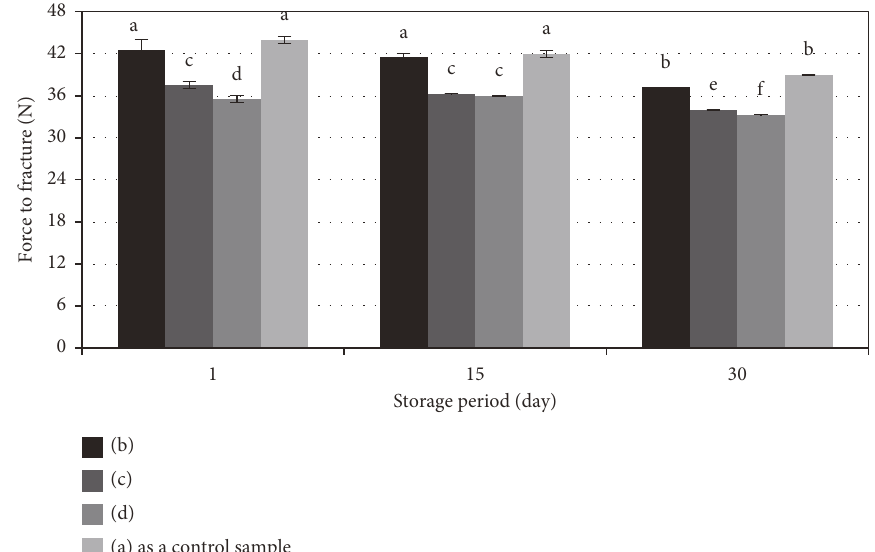
Figure 2: Changes in force to fracture (N) during storage of Iranian UF cheese ∗ treated by KCl and NaCl during 30 days of storage period. ∗ (a) 3% NaCl (control), (b) 1.50% NaCl+1.50% KCl, (c) 1.00% NaCl+2.00% KCl, and (d) 0.75% NaCl+2.25%